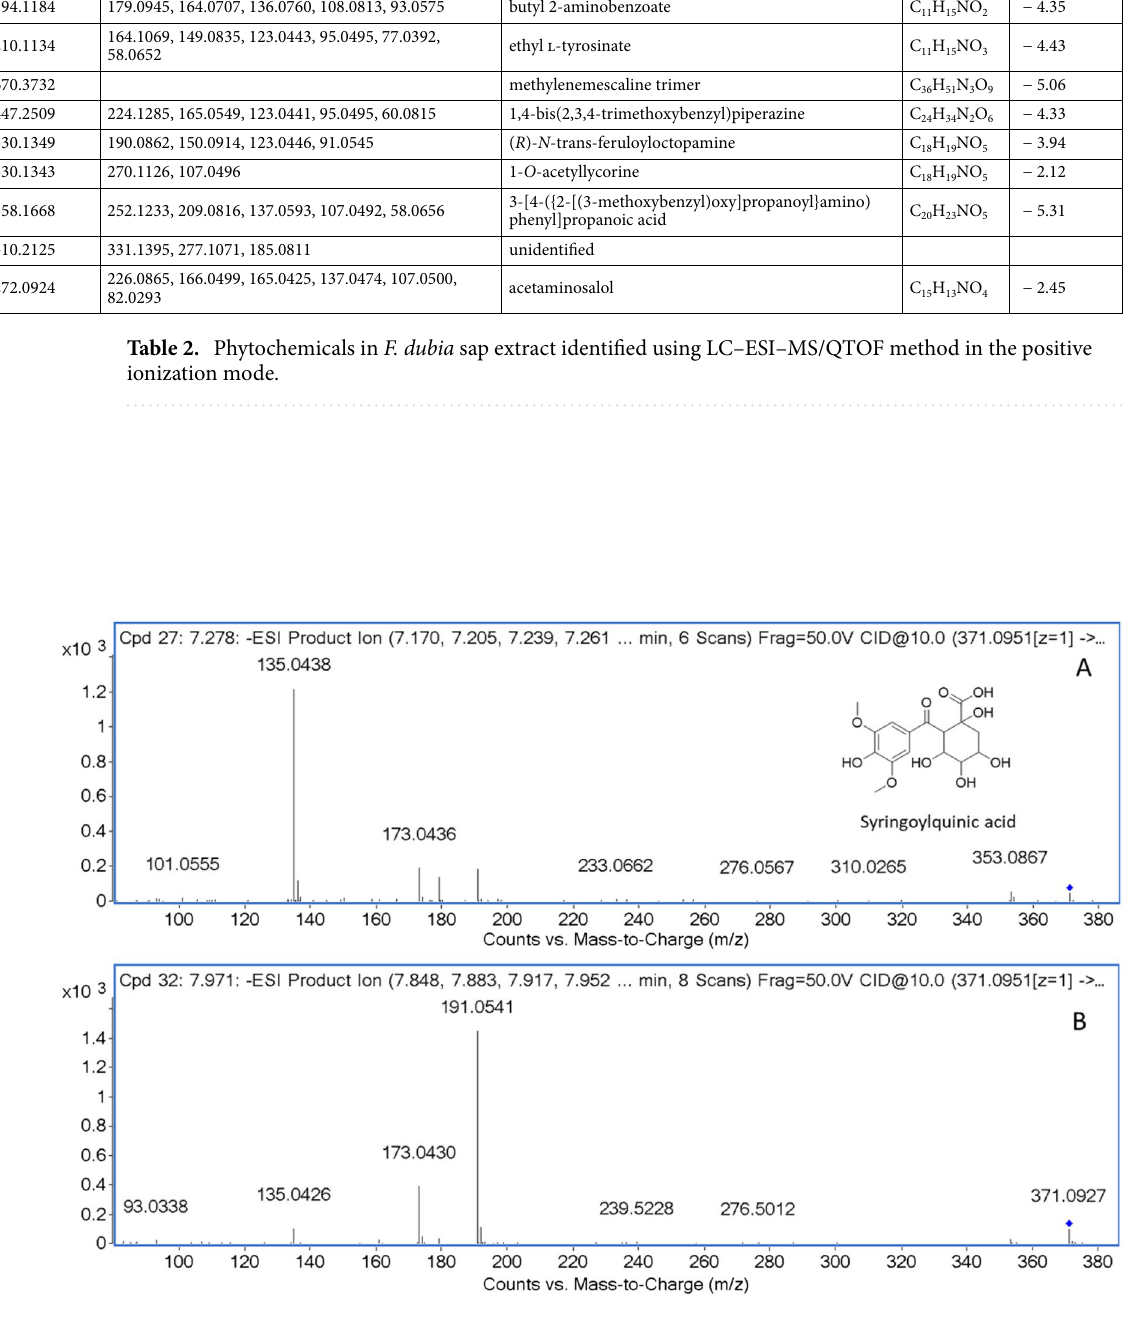
Figure 2. MS/MS data and proposed structure of syringoylquinic acid, compound 6 ( A ), and 7 ( B